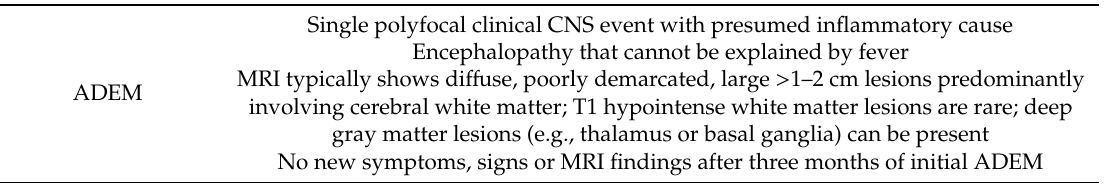
Criteria for acute disseminated encephalomyelitis (ADEM) and relapsing disorders following ADEM.